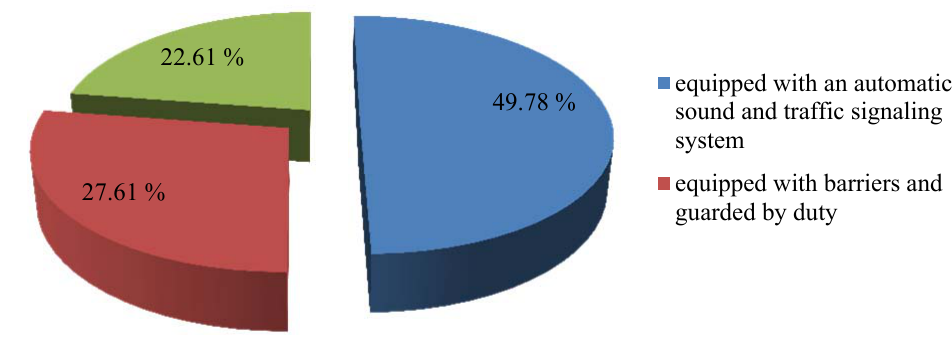
Fig. 2. Distribution of traffic accidents on the railway, depending on the